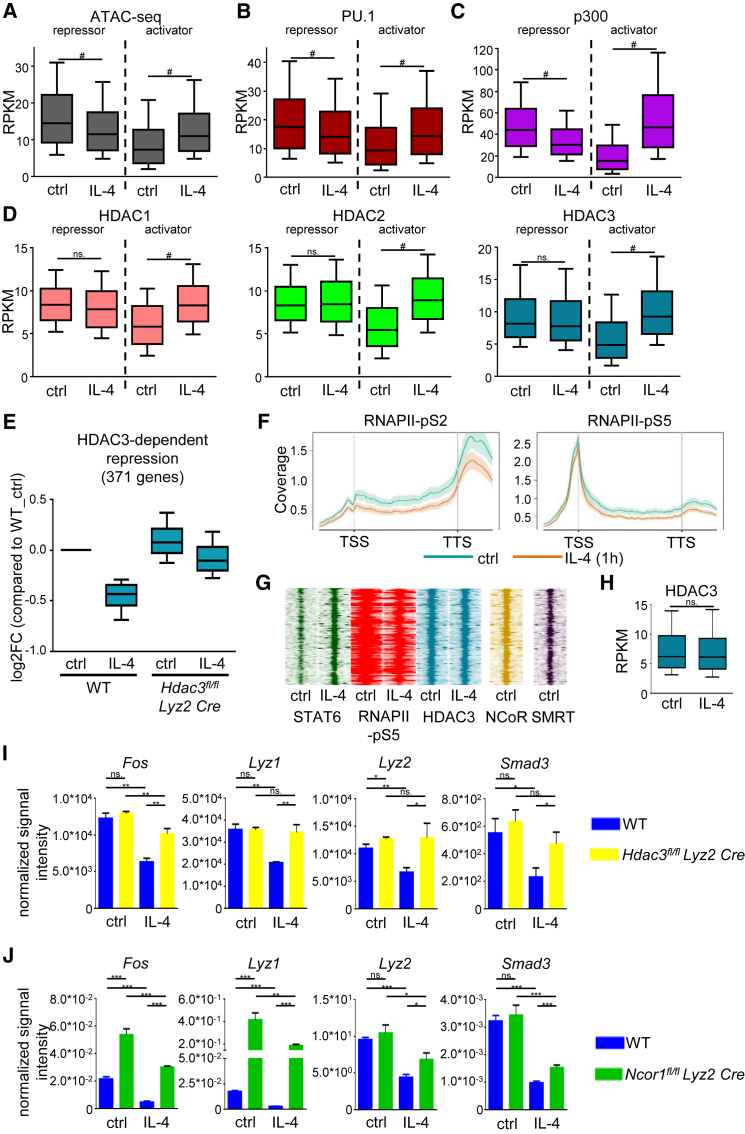
IL-4-Induced Changes at Repressor and Activator STAT6 Sites and the Role of HDAC3 in IL-4-STAT6-Mediated Repression(A–D) Boxplots of ATAC-seq (A) and ChIP-seq (B–D) signals for PU.1 (B), p300 (C), HDAC1 (D), HDAC2 (D), and HDAC3 (D) on the repressor and activator STAT6 sites in WT BMDMs. Boxes encompass the 25th to 75th percentile RPKMs. Whiskers extend to the 10th and 90th percentiles.(E) Boxplots of the expression of IL-4-HDAC3-dependent repressed genes in WT (n = 3) and Hdac3fl/fl Lyz2 Cre (n = 3) BMDMs using publicly available microarray results. Boxes encompass the 25th to 75th percentile changes. Whiskers extend to the 10th and 90th percentiles.(F) Metagene plots of RNAPII-pS5 and RNAPII-pS2 signals at the gene bodies of IL-4-HDAC3-dependent repressed genes. Coverage is defined as read count per million mapped reads.(G) Read distribution plot of ChIP-seq intensities for RNAPII-pS5, STAT6, HDAC3, NCoR, and SMRT around the summit of the detected STAT6 peaks at the IL-4-repressed enhancers (n = 325) in the subTADs of HDAC3-dependent repressed genes, 1 hr of IL-4 stimulation.(H) Boxplot of the average HDAC3 binding intensity on the genomic regions (G). Boxes encompass the 25th to 75th percentile RPKMs. Whiskers extend to the 10th and 90th percentiles.(I) Normalized microarray signal intensity of Fos, Lyz1, Lyz2, and Smad3 in control or IL-4-stimulated WT and Hdac3fl/fl Lyz2 Cre BMDMs.(J) RT-qPCR measurements of Fos, Lyz1, Lyz2, and Smad3 expression in control or IL-4-stimulated WT and Ncor1fl/fl Lyz2 Cre iBMDMs.BMDMs were treated with IL-4 for 1 hr (A–D, F–H) or 24 hr (E, I, and J). Data (A–D, F, and H) are combined from two independent biological replicates. Changes (A–D and H) were considered significant at p < 0.00001 using paired t test and an average fold change cut off value of ≥ 1.15 was used between control and IL-4-treated samples. # means significant difference, ns indicates not significant change. Data (I) represent the mean and SD of three independent biological replicates. ∗p < 0.05, ∗∗p < 0.01, ∗∗∗p < 0.001, ns, no significant difference. Error bars represent means ± SD. Data (J) represent the mean and SD of three independent biological replicates. ∗p < 0.05, ∗∗p < 0.01, ∗∗∗p < 0.001, ns, no significant difference. Error bars represent means ± SD.